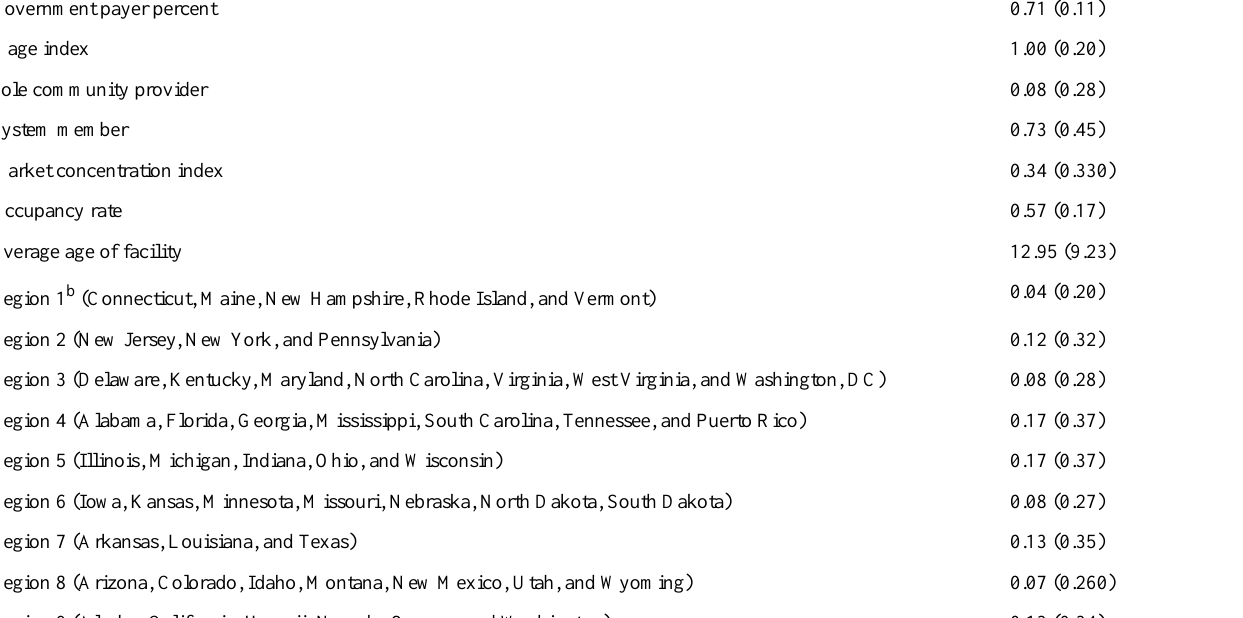
any of the vendors, when compared with facilities that fall into the “other” category. Thus, we can say, on average, and when controlling for the numerous organizational factors as controls, none of the EHRs are associated with favorable or unfavorable financial outcomes as measured by net